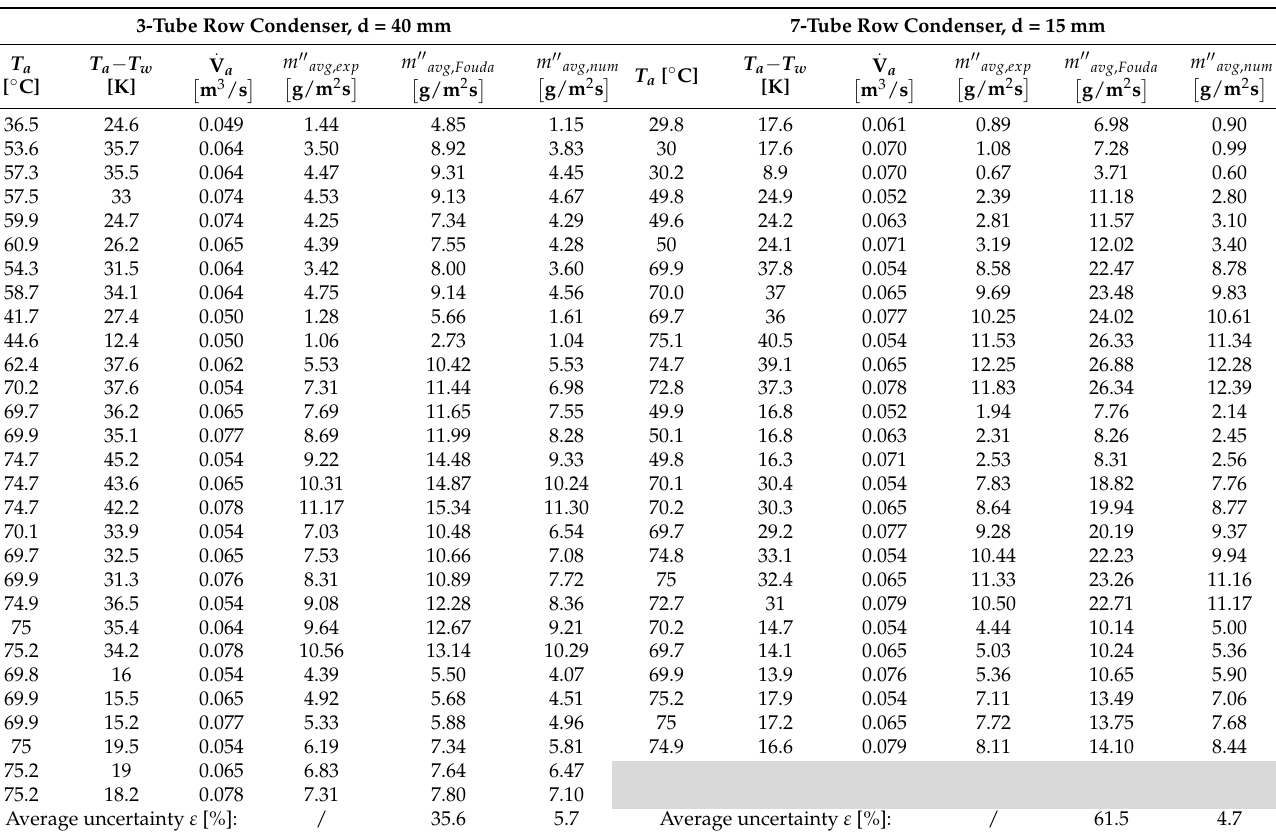
) at different parameters: avg , num